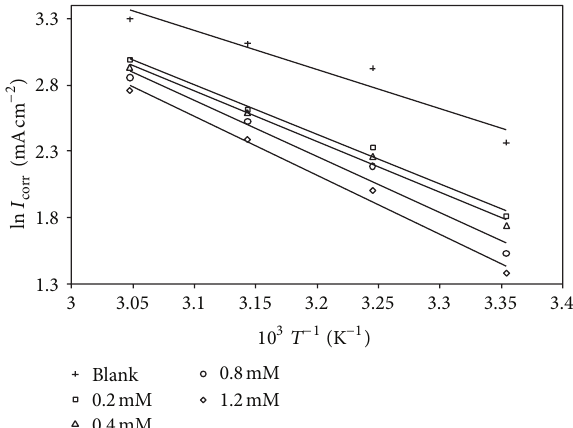
) versus 1/𝑇 of 1M corr